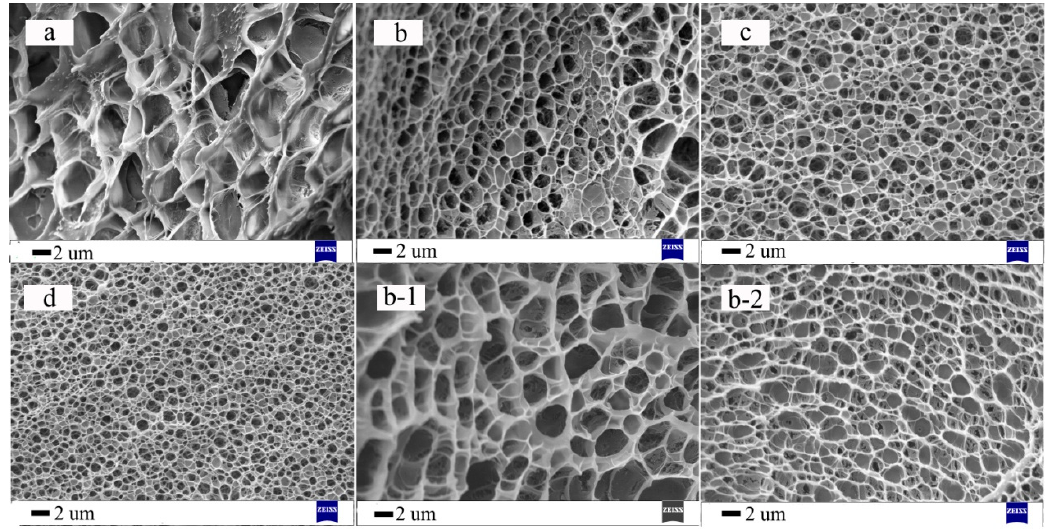
Figure 3. The surface morphology of hydrogels. ( a ) ACX-gel with C = 2.5 wt %; ( b ) ACX-gel with C = 5.0 wt %; ( c ) ACX-gel with C = 7.5 wt %; ( d ) xylan-gel with C = 10.0 wt %; ( b-1 ) xylan-gel with C = 5.0 wt %; ( b-2 ) AXC-MNP-gel with C = 5.0 wt %. Scale bar: 2 µm.